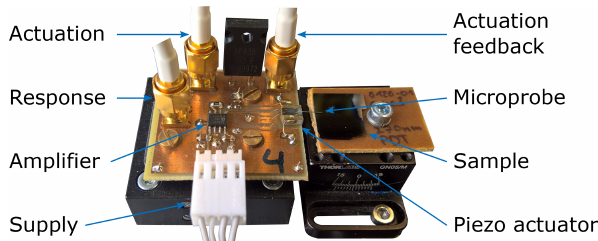
Figure 3. Photograph of a microprobe carrier PCB next to a sample under test.